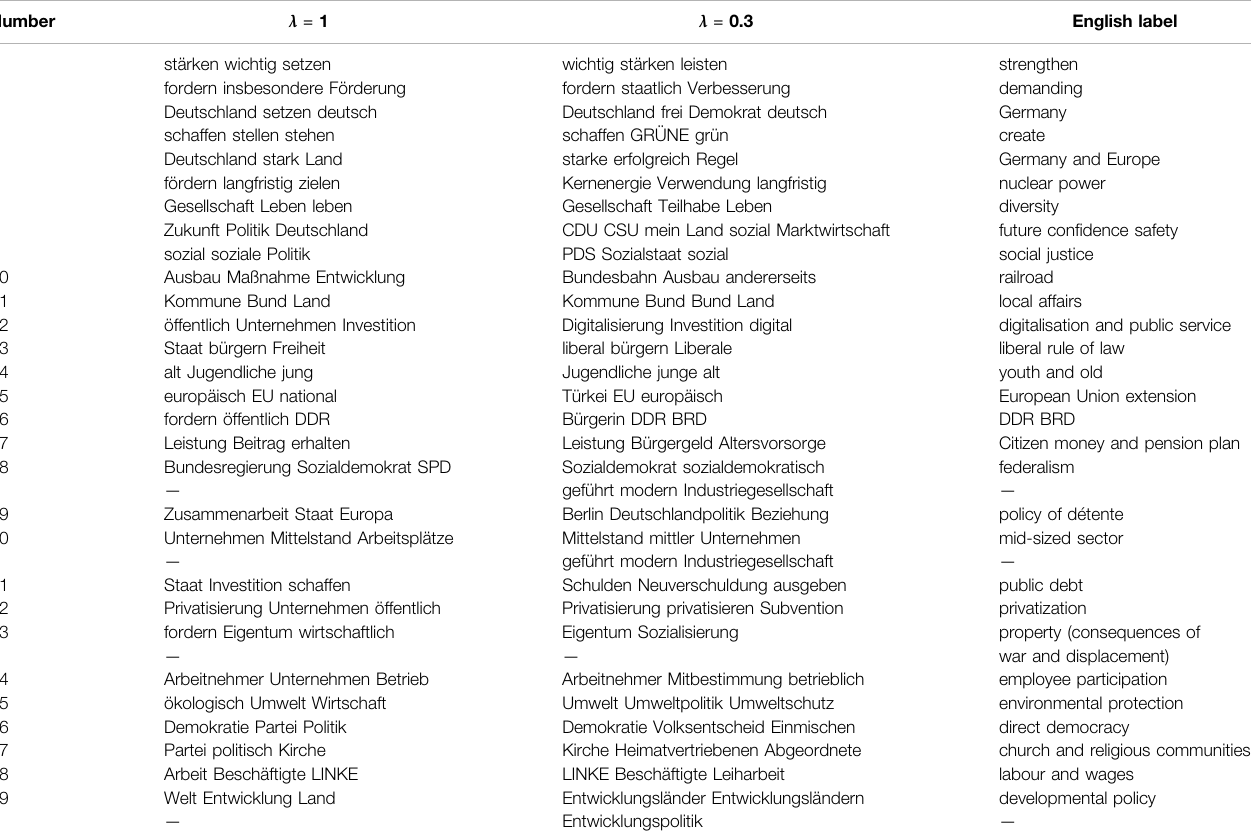
TABLE 1 | First 30 topics of topic model A trained on German manifestos from 1949 to 2017. Shown are the three most relevant words for λ (cid:1) 0 and λ (cid:1) 0.3 (see Eq. 1 ) and the assigned English